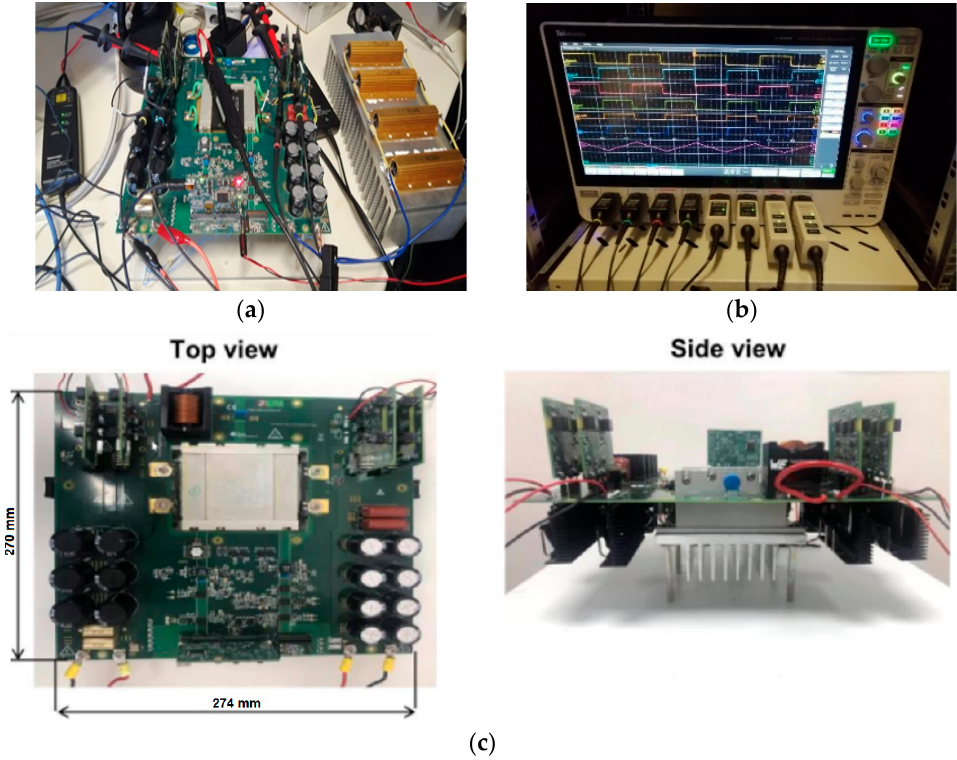
Figure 13. TIDA 010054 Board: ( a ) experimental setup; ( b ) oscilloscope measuring the key waveforms of the DAB converter; ( c ) top and side view.